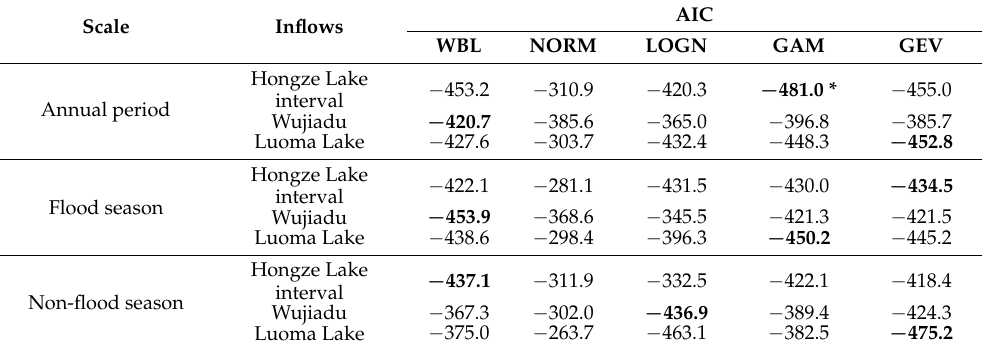
Table 2. The AIC values of each marginal distribution. Scale Inflows